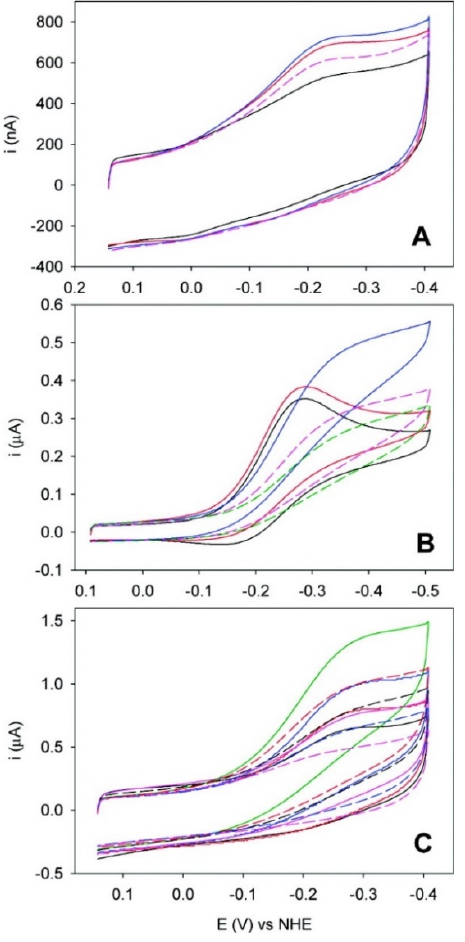
Figure 3. Cyclic voltammograms recorded in the presence of increasing concentrations of sodium nitrite for the M80A variant of yeast iso-1-cytochrome c immobilized with different procedures on a polycrystalline gold electrode at pH 7. ( A ) M80A/C102T on a SAM 4-MP (black, no nitrite; red, 10 μ M; blue, 20 μ M; magenta, 100 μ M), ( B ) M80A/C102T on a SAM of MUA/MU (black, no nitrite; red, 1 μ M; blue, 5 μ M; magenta, 15 μ M; green, 20 μ M), and ( C ) M80A/N62C/C102T covalently linked to the electrode through an Au-S(Cys) bond (black, no nitrite; red, 1 μ M; magenta, 2 μ M, blue, 5 μ M; green, 10 μ M; dashed red, 20 μ M; dashed black, 30 μ M; dashed magenta, 50 μ M). For the solution composition and other experimental conditions, the reader is referred to the original literature. Reprinted with permission from ref. [8]. Copyright 2008 American Chemical Society.